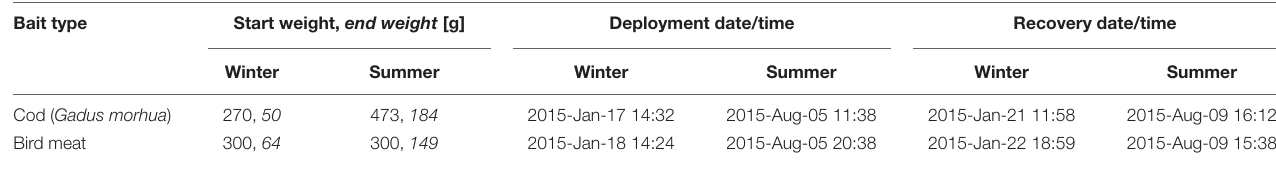
TABLE 1 | Time-lapse recording details by bait type and